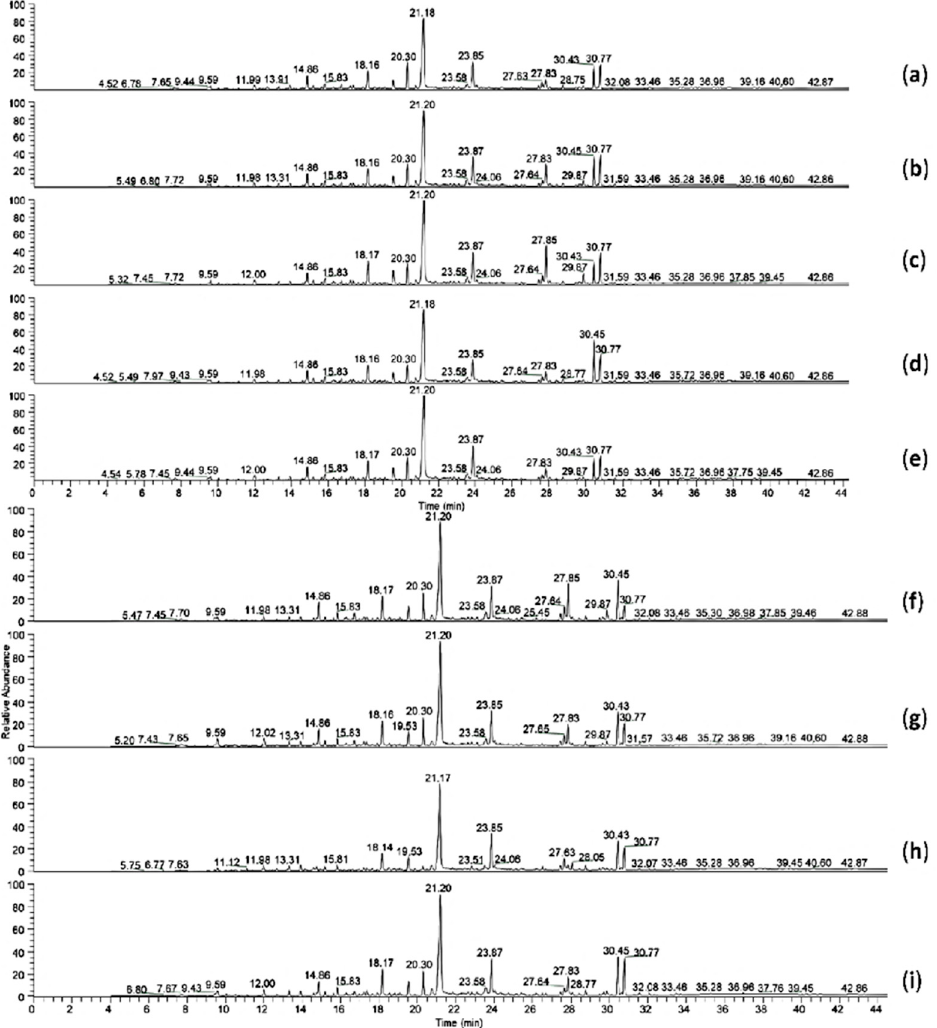
Figure 5. GC-MS chromatograms of crude oil degradation caused by ( a ) control; ( b ) Bacillus swezeyi LFS15 after 14 days; ( c ) Bacillus swezeyi LFS15 after 8 months; ( d ) Shinella zoogloeoides LFG9 after 14 days; ( e ) Shinella zoogloeoides LFG9 after 8 months; ( f ) Pseudomonas guguanensis SGPP2 after 14 days; ( g ) free consortium COG1 after 5 months; ( h ) entrapped consortium COG1E after 5 months; ( i ) entrapped consortium supplemented with SDS as COG1ES after 5 months.